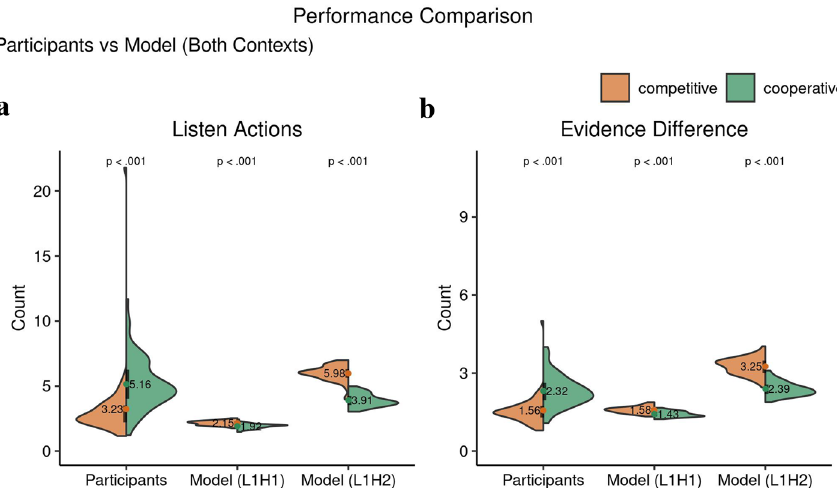
Figure 8. Interactive choice behavioral indices’ (listen actions and evidence-difference) comparison of the multiagent version of the ITT between participants and IPOMDP models, competitive and cooperative contexts. The figure shows the mean values with their distributions in the form of split violin plots. The black bars cover the interquartile range. The number of listen actions are significantly higher in the cooperative context for participants and the converse is true for both the IPOMDP models as seen in ( a ). Similar relations are observed in ( b ) for participants and both models for